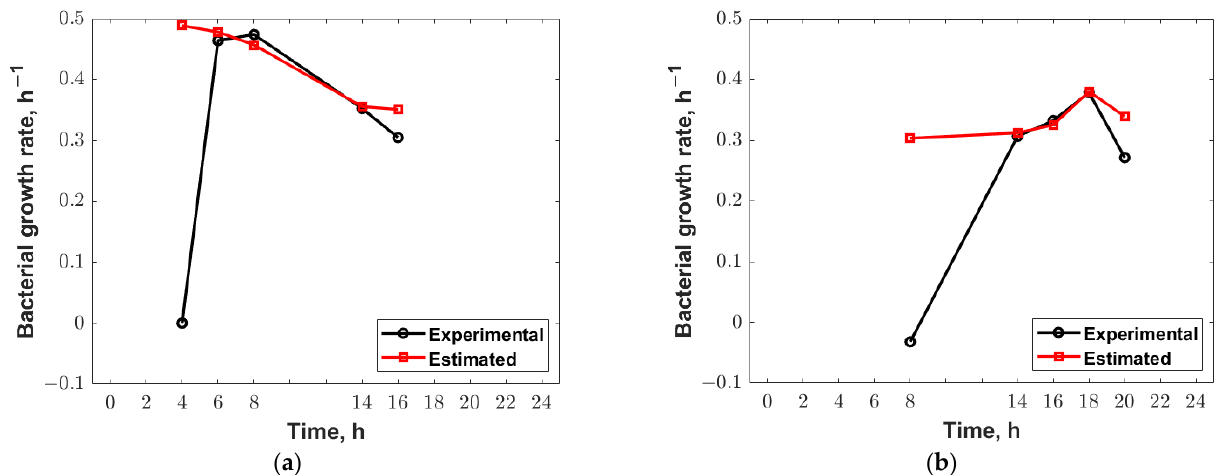
Figure 7. Trends of the bacterial growth rates estimated using the logistic model: ( a ) without and ( b ) under pH control.